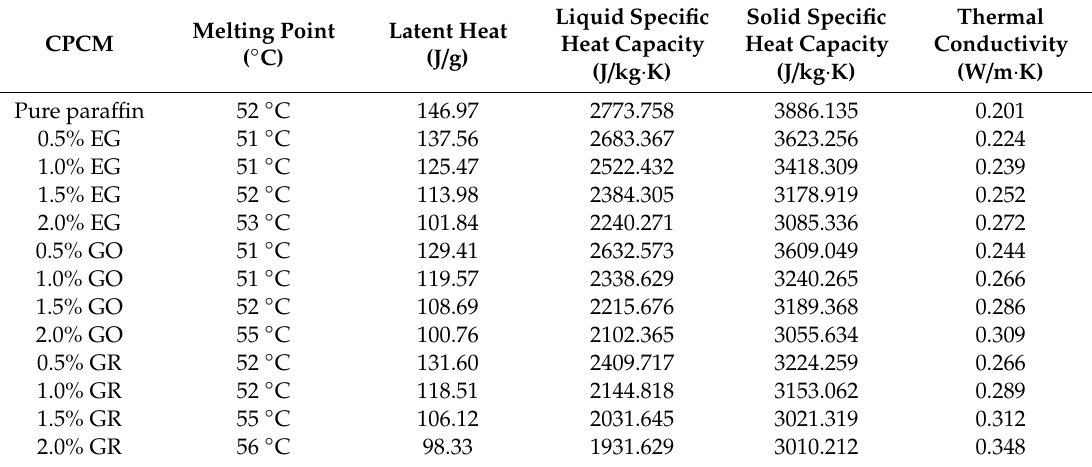
Table 2. The thermophysical properties of